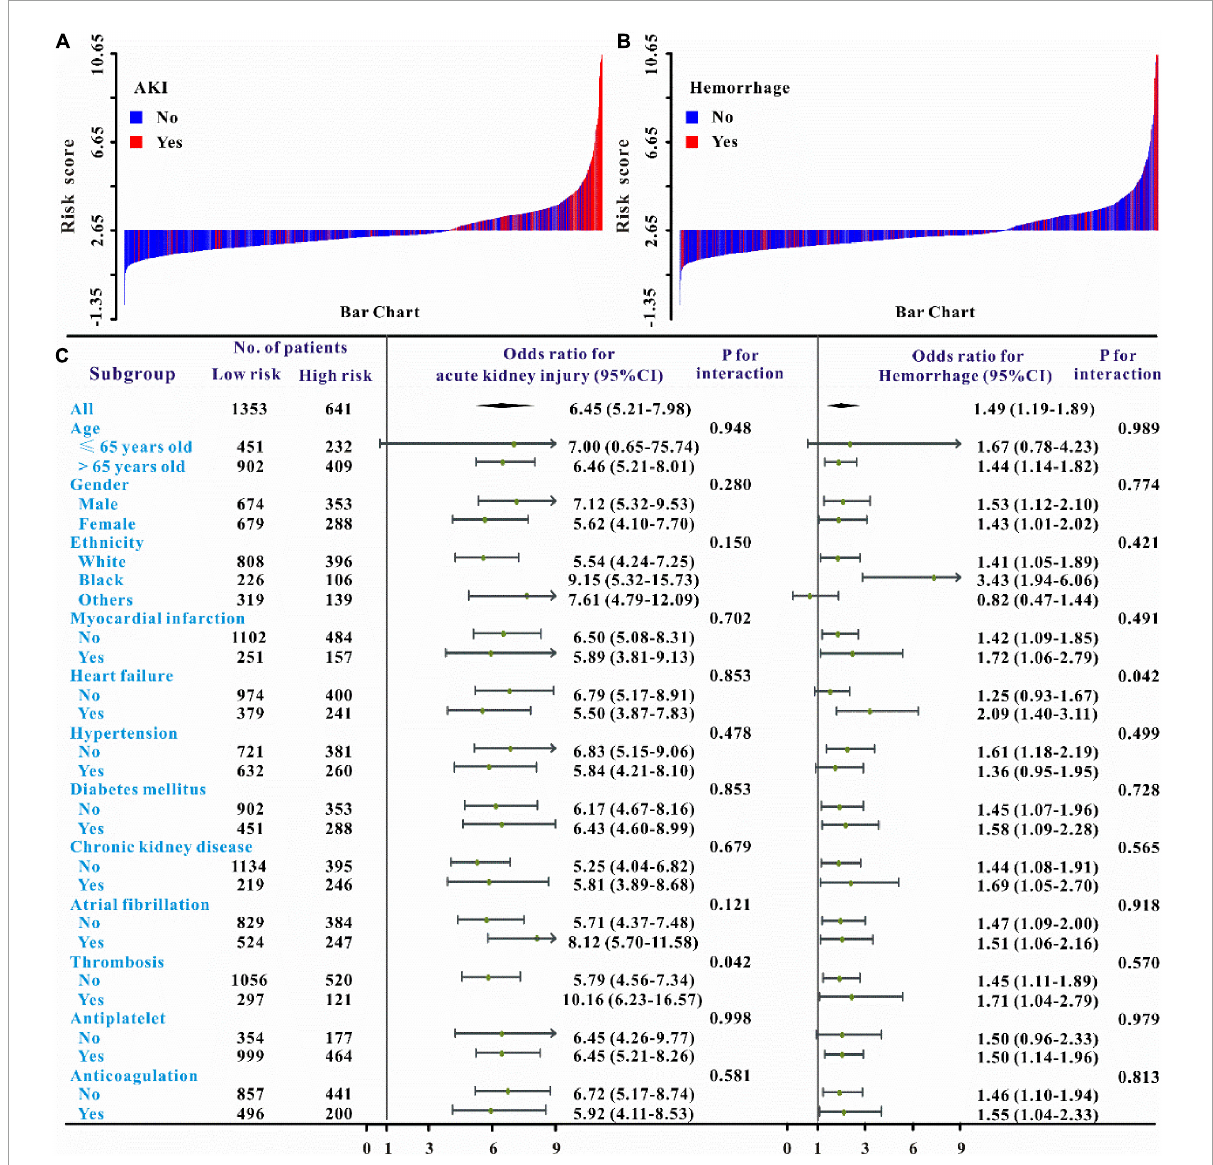
FIGURE3 Waterfall plots and forest plots of the high-risk group and low-risk group for the prediction of AKI and intracerebral hemorrhage among critically ill patients with IS. The waterfall plot of the risk score for each patient of AKI (A) and intracerebral hemorrhage (B) . The subgroup analysis of the risk score in individuals with critically ill IS for AKI and intracerebral hemorrhage (C) .